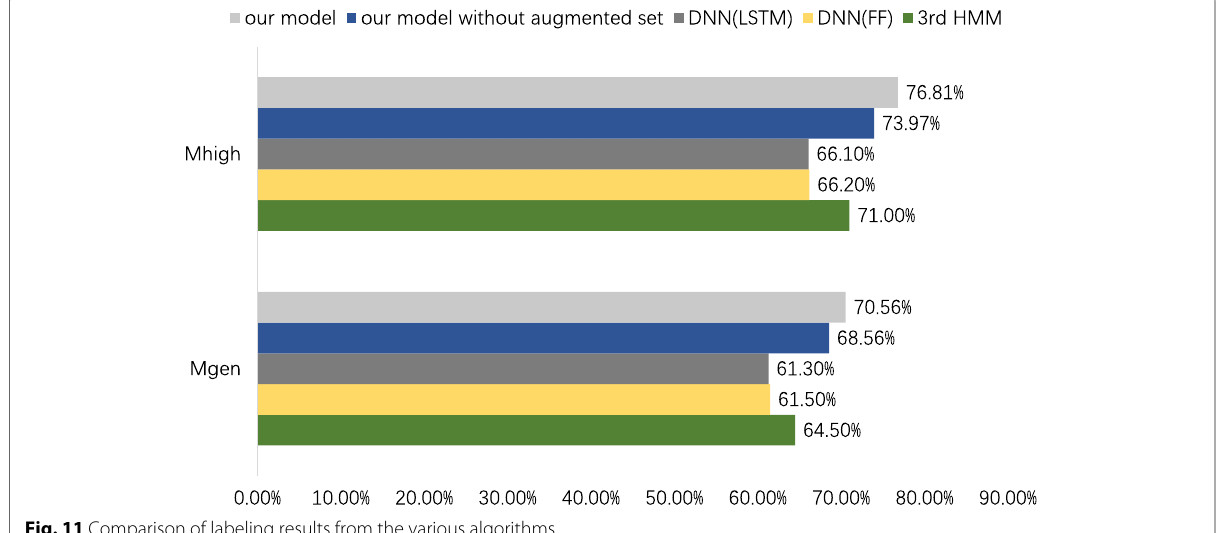
Fig. 11 Comparison of labeling results from the various algorithms